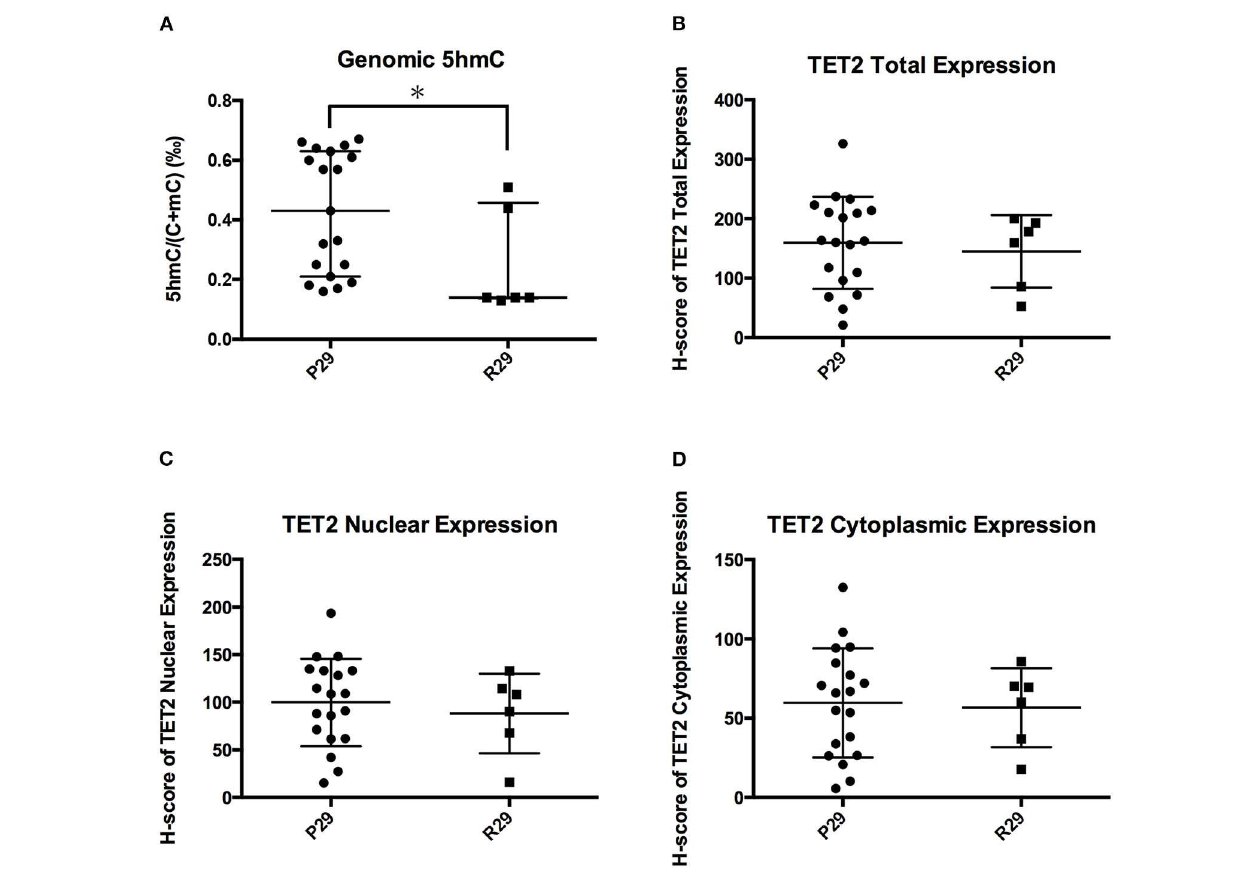
FIGURE 7 | Influence of TET2 p.P29R on TET2 expression and localization. (A) Genomic 5hmC levels in the R29 group were lower than those in the P29 group. (B) TET2 total expression was not significantly different between the R29 group and the P29 group. (C) TET2 nuclear localization was not significantly different between the R29 group and the P29 group. (D) TET2 cytoplasmic localization was not significantly different between the R29 group and the P29 group. * P < 0.05